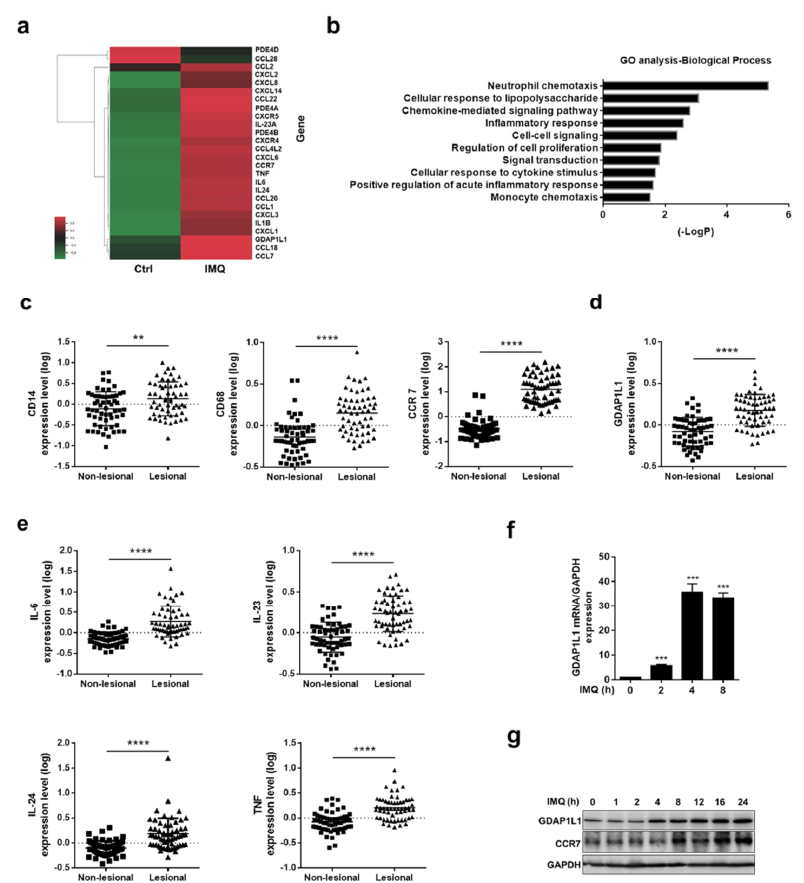
Figure 1. GDAP1L1 and inflammatory cytokines were upregulated in IMQ-induced macrophages and psoriatic patients. ( a ) Selected immune-associated genes significantly increased and ( b ) GO cluster classified the differentially expressed genes in macrophages by IMQ stimulation (fold ≥ 1.5). Gene expression data of skin from psoriatic patients in Gene Expression Omnibus (GEO) dataset GSE13355 were analyzed for ( c ) the expression of the macrophage markers CD14, CD68, and CCR7, and ( d ) the mitochondrial fission factor GDAP1L1, as well as ( e ) the expression of the key inflammation cytokines IL-6, IL-23, IL-24 and TNF in tissue with and without lesions from psoriatic patients ( n = 58). ( f , g ) q-